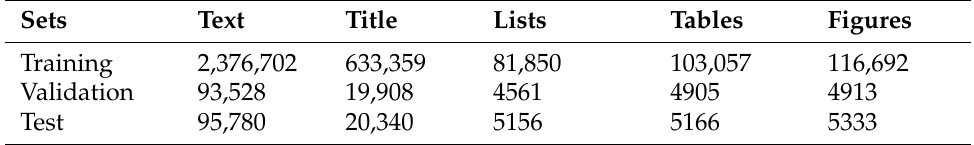
Table 4. Statistics of training, validation, and testing sets in PubLayNet [44]